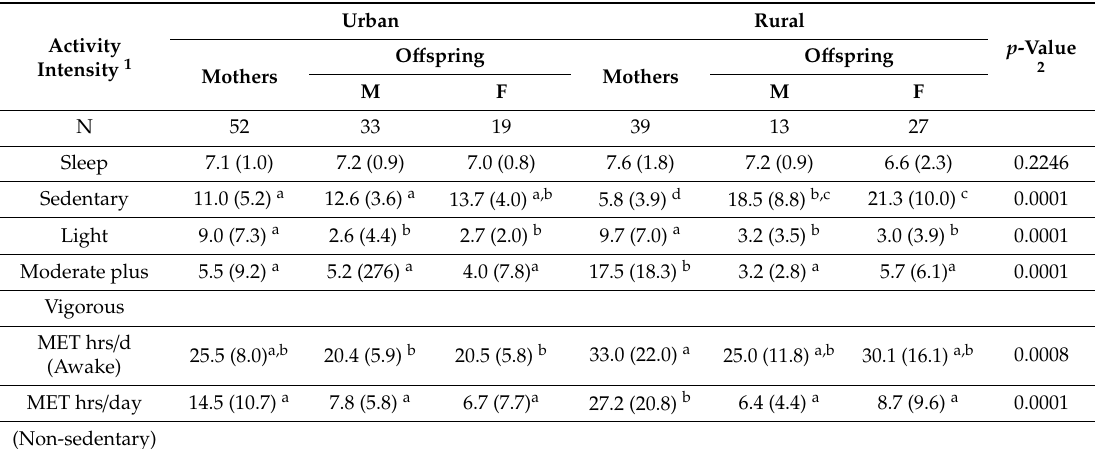
Table 6. Metabolic equivalent of task (MET) hrs / d from di ff erent activity intensities by Chinese mothers and o ff spring based on the CCFC Physical Activity